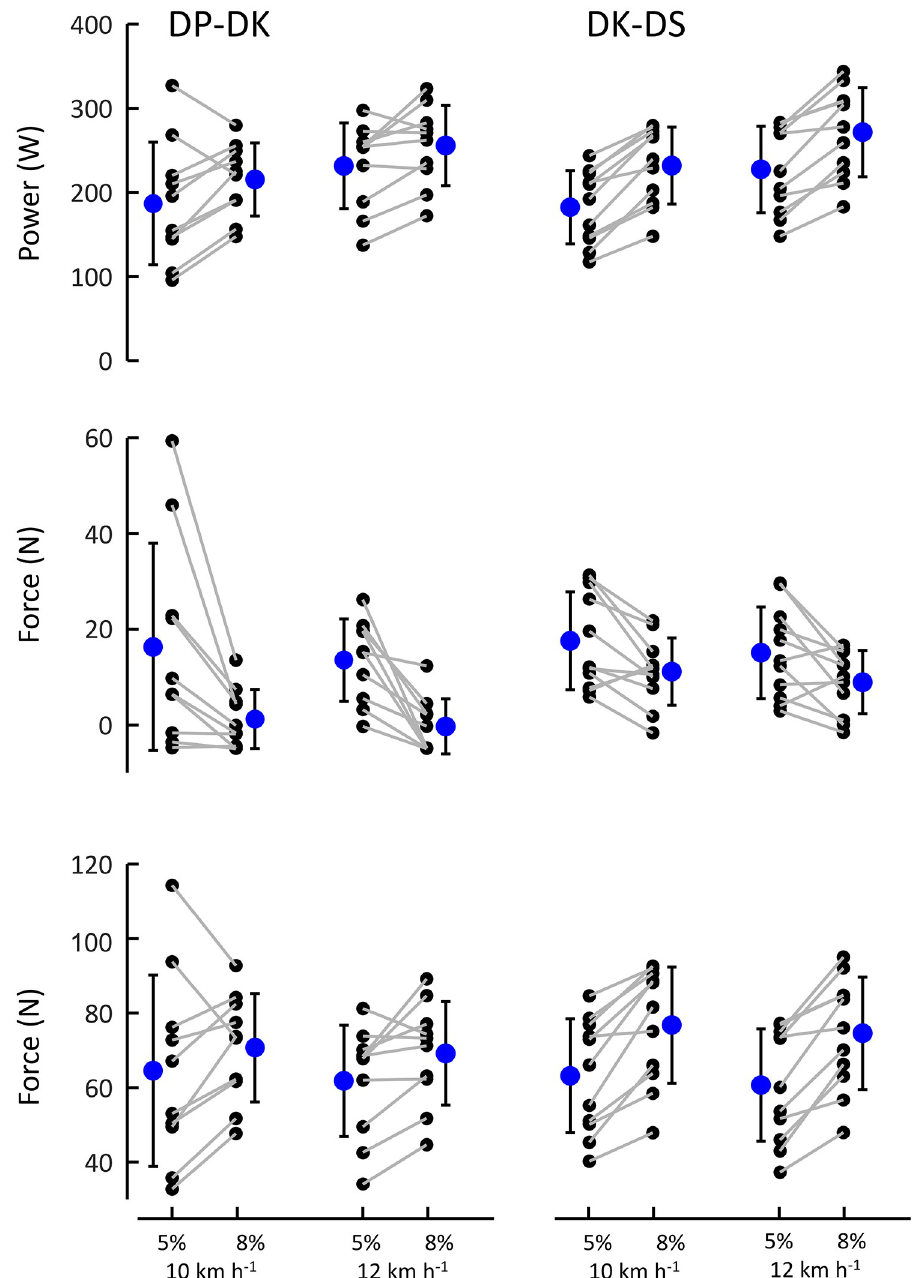
Fig 4. Mean, SD and individual values of (A) mechanical power, (B) additional resistive force and (C) total resistive force at technique transitions. Grey connecting lines indicate individual data from the same athlete. For reasons of clarity, these are only shown between different inclines at the same